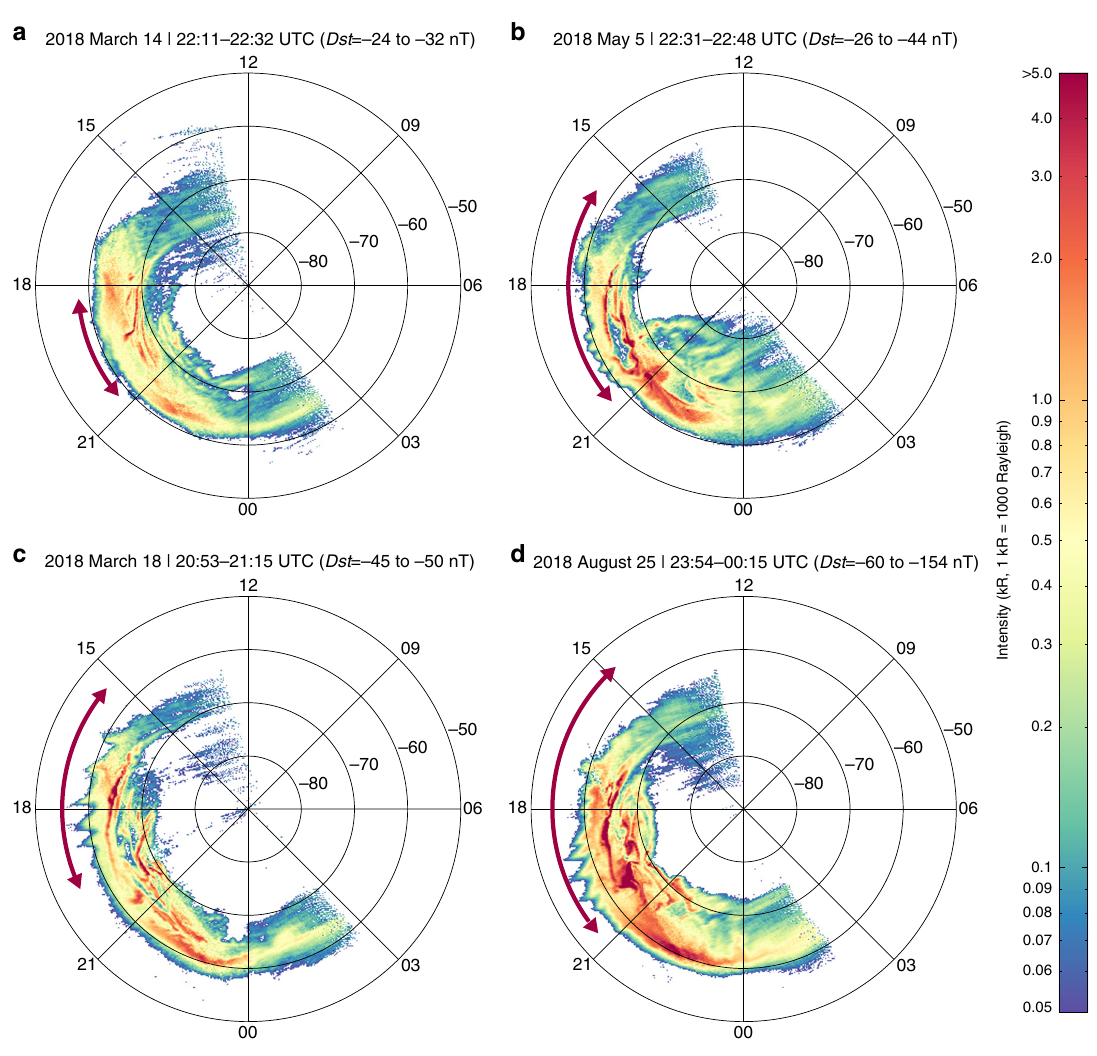
Fig. 5 SAs observed by FY-3D WAI during four geomagnetic storms in 2018. All the images observed between a 22:11 – 22:32 UTC on 14 March 2018, sphere at a height of 110 km in the AACGM – MLT coordinate system. The SAs are highlighted by the red arrows. Detailed structural parameters of the SAs are listed in Table 1.